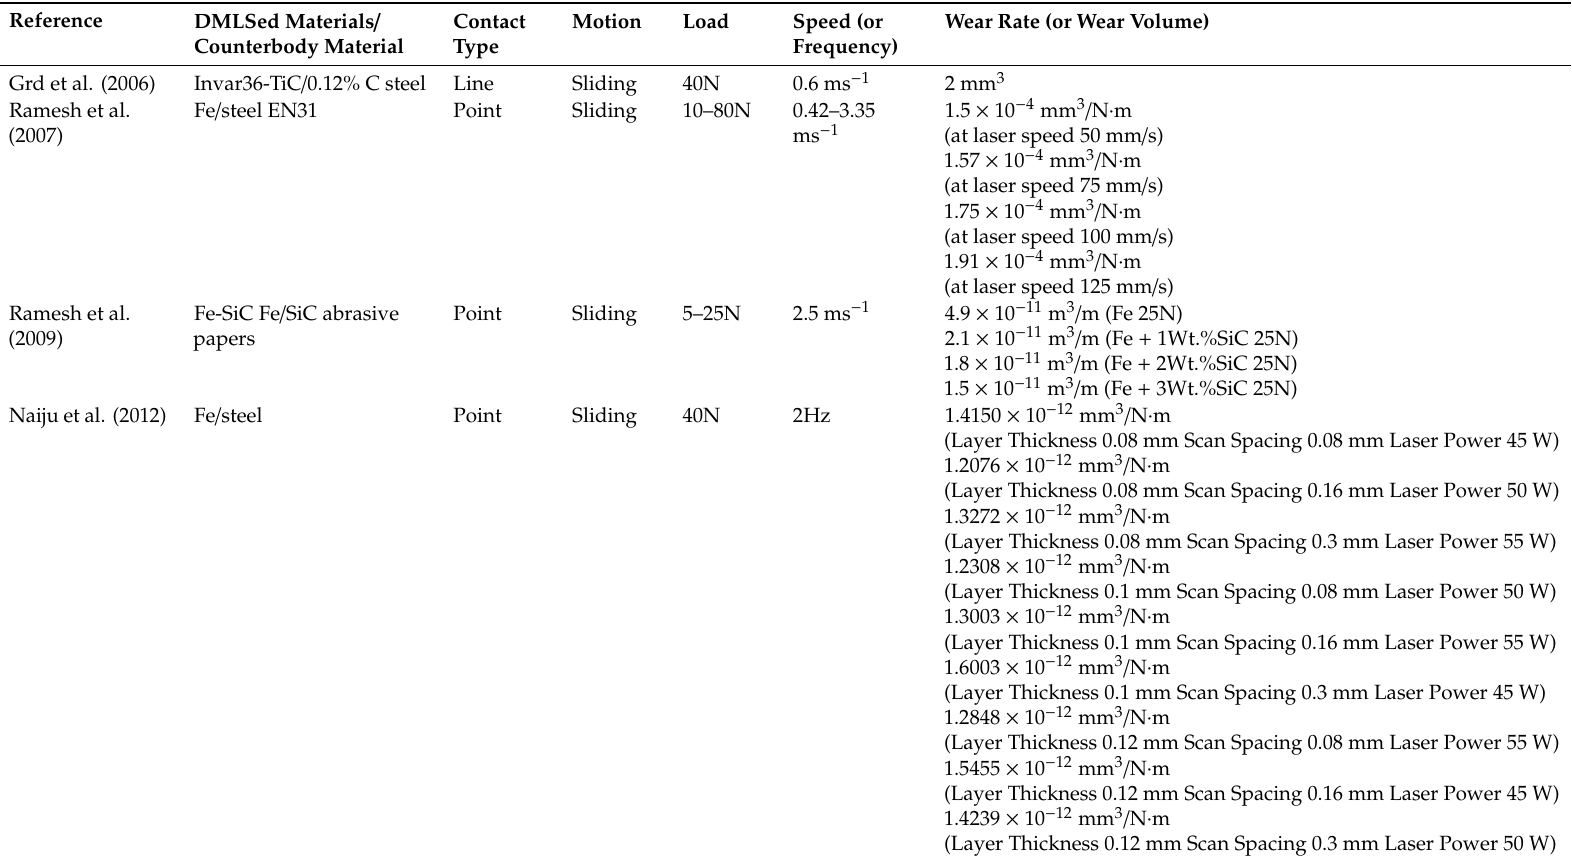
Table 1. Contact conditions and wear rates under dry